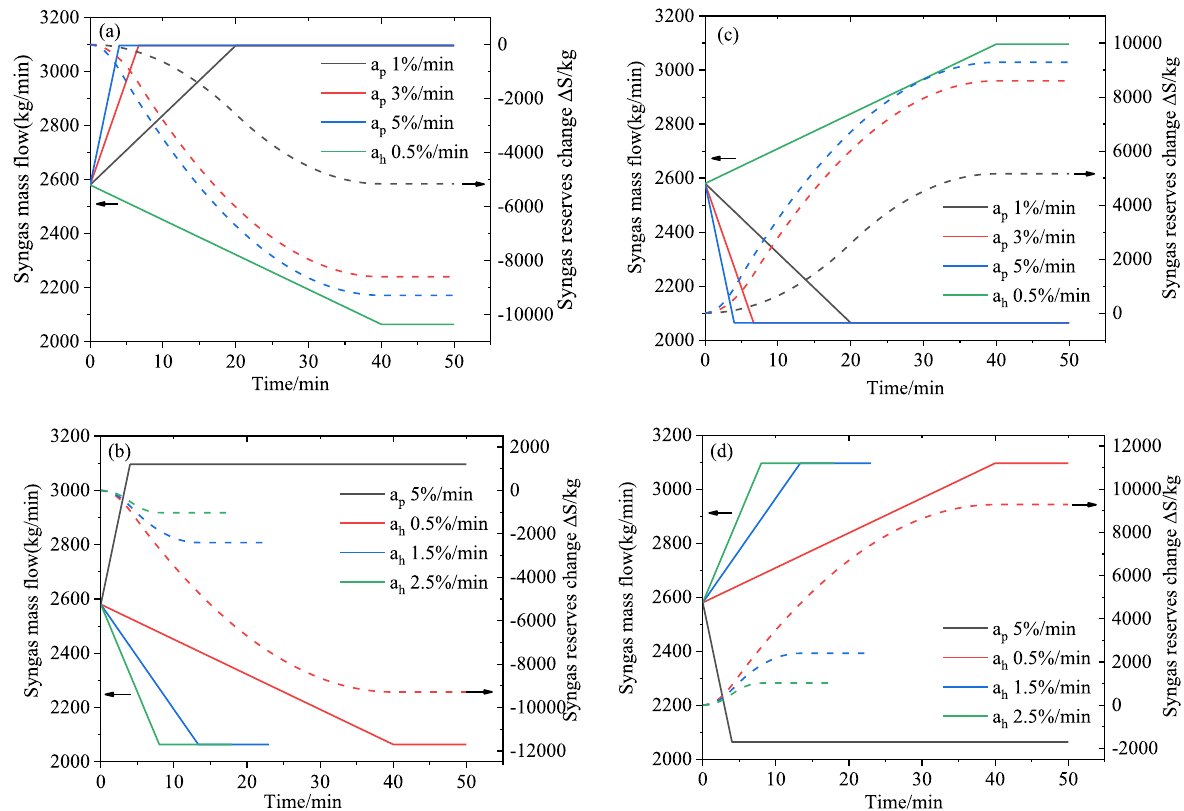
Fig. 3 Syngas reserve change with the various load change rates of the power generation and hydrogen generation unit ( a results of the power output increase at the different ramp rates of the power generating unit; b results of the power output increase at the different load change rate of the hydrogen production unit; c results of the power output decrease at the different ramp rates of the power generating unit; d results of the power output decrease at the different load change rates of the hydrogen production unit; a g , a h and a p are the load change rates of the gasification, hydrogen production and power generating units,